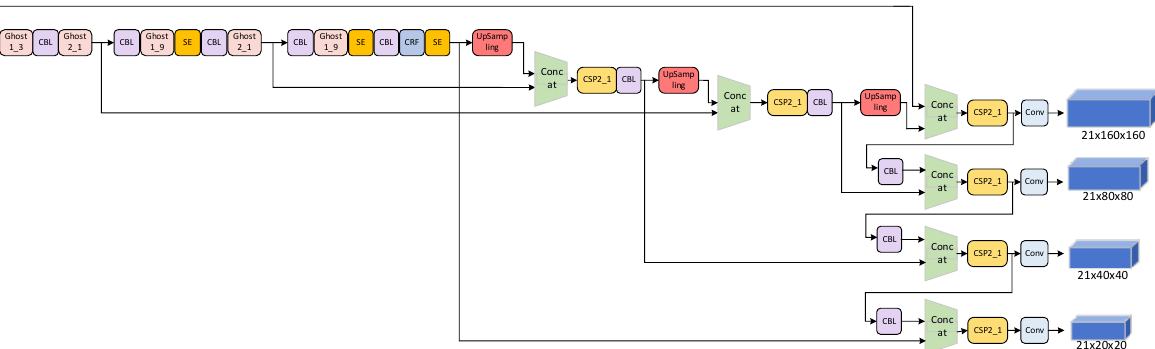
Figure 5. Improving the overall structure of YOLOv5 .